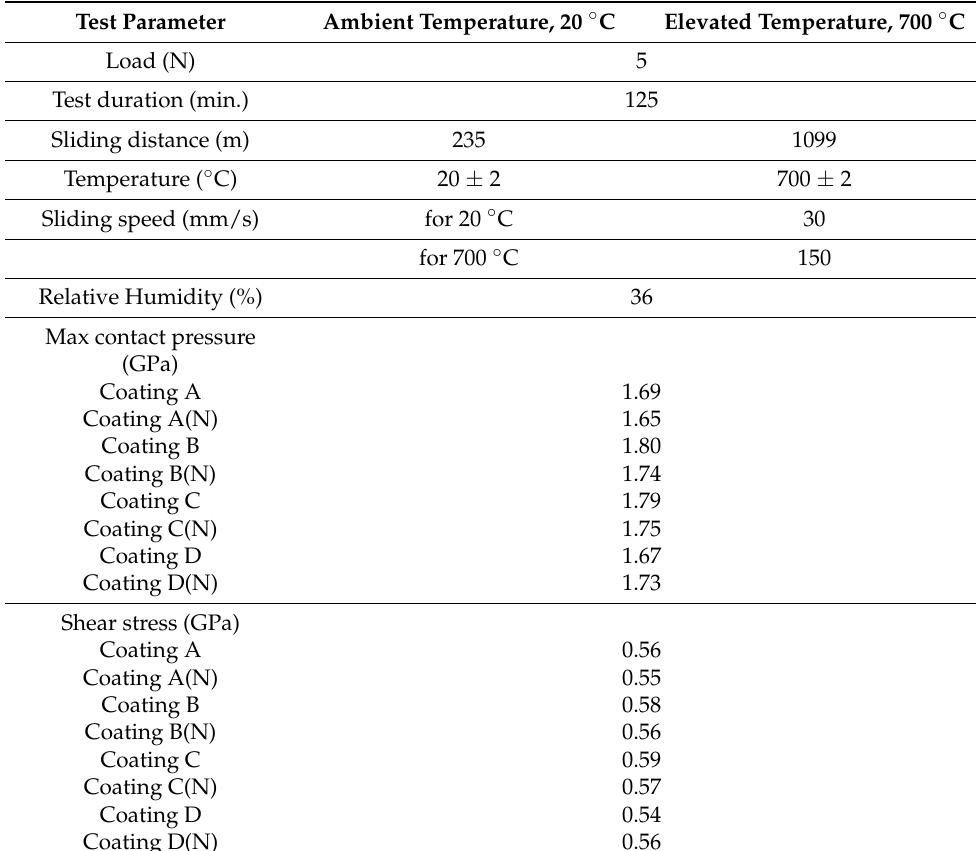
Figure 2. Ball-on-disk tribometer with high-temperature testing module and a scene from wear test at 700 °C with the alumina ball, optical microscope, and AFM images. Table 2. Tribometer test conditions of A, B, C and D coatings deposited on non-nitrided and nitrated specimens (marked as (N)).